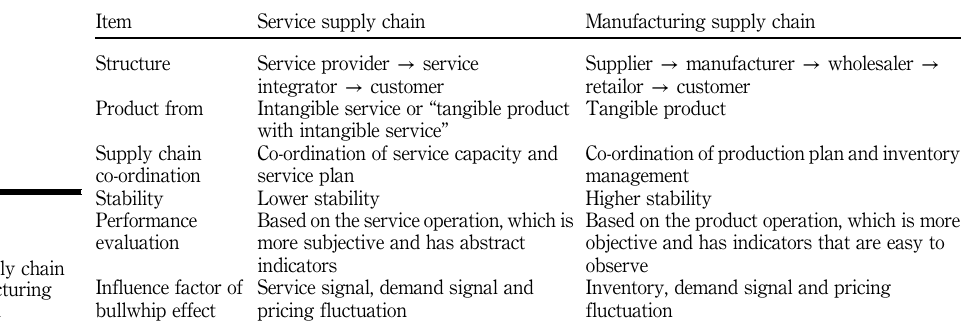
Table I. Service supply chain and manufacturing supply